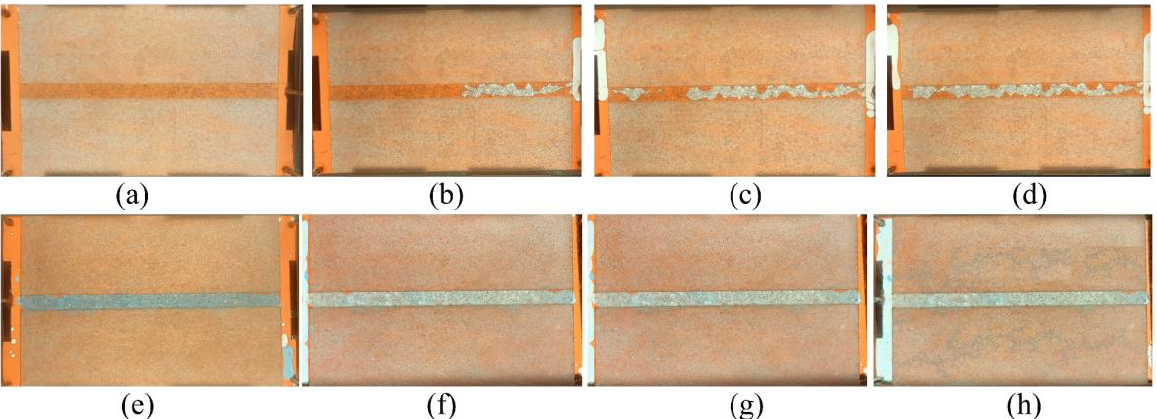
Figure 13. Flue gas flooding in visual glass plate model: ( a ) saturated with oil; ( b ) initial stage of gas flooding;( c ) intermediate stage of gas flooding; ( d ) final stage of gas flooding; ( e ) polymer gel formed in the high permeability area; ( f ) initial stage of subsequent gas flooding;( g ) intermediate stage of subsequent gas flooding; ( h ) final stage of subsequent gas flooding.